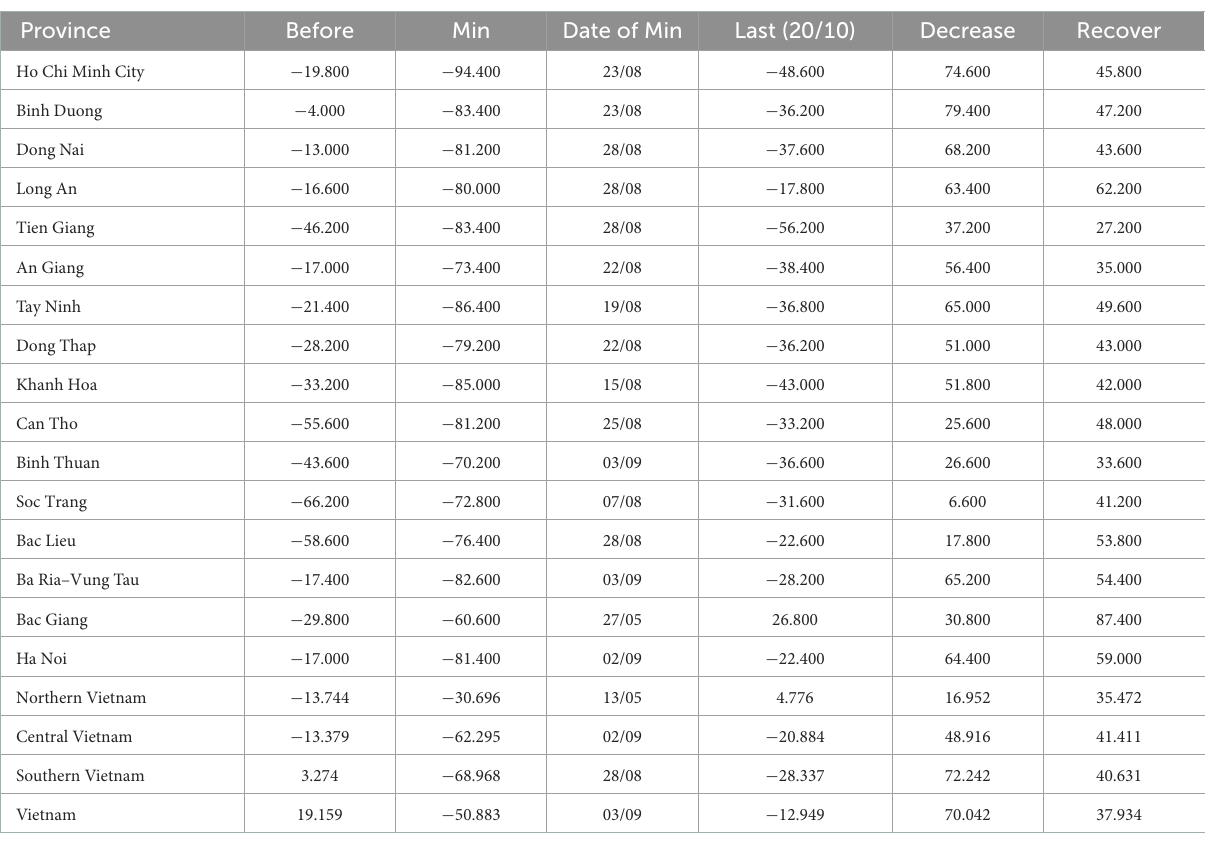
TABLE 2 Variation of MR i by province.